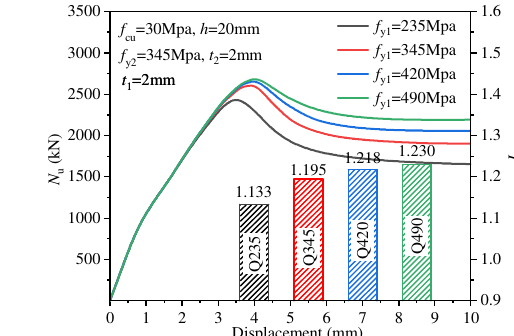
( b ) Influence of yield strength of corrugated steel plate. Figure 14. Cont